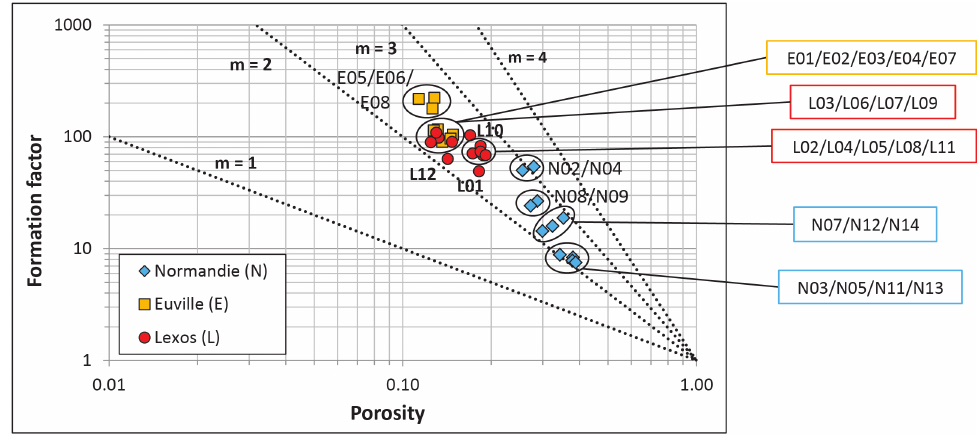
Figure 3. Crossplot of formation factor over porosity depending on the rock type. Diamonds are for Normandie, squares for Euville and circles for Lexos. Lines of equal cementation factors according to Archie’s law (Equation (5)) are also displayed.